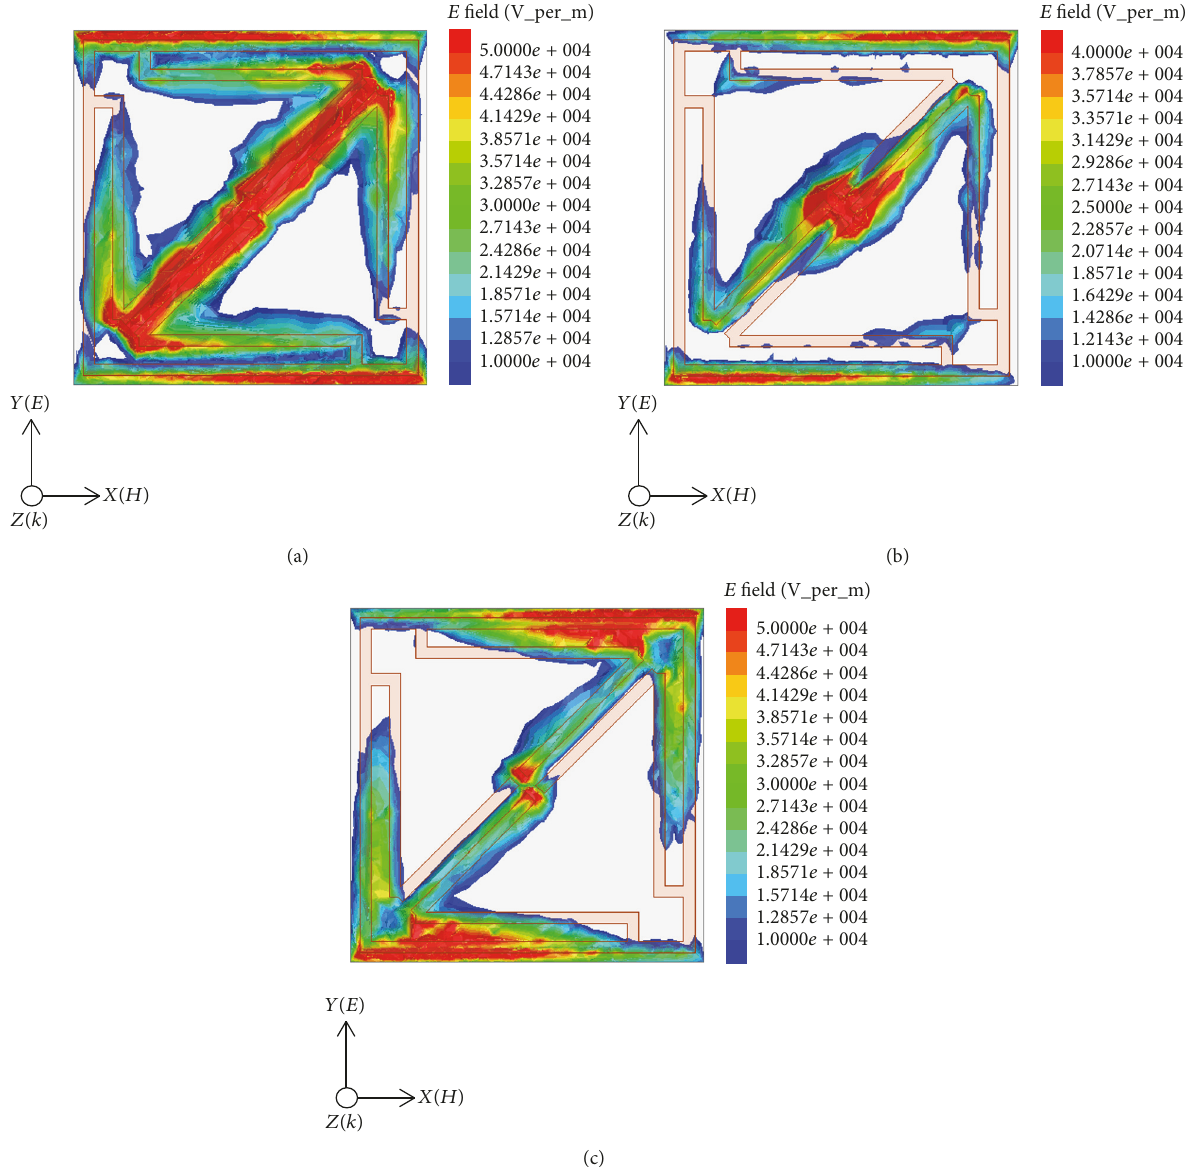
Figure6:MagnitudeofelectricfielddistributionontheTBEMRmetamaterialatresonantfrequencies(a) 𝑓 01 = 4.32 GHz,(b) 𝑓 02 = 7.55 GHz, and 𝑓 03 = 9.76 , respectively. Note that red color indicates strong positive